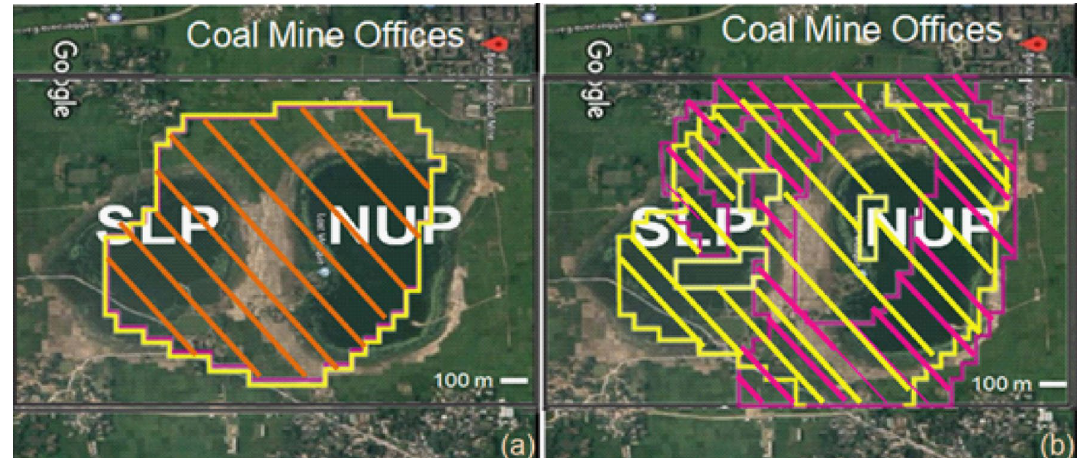
Figure 13. Future subsidence scenario of the mine area due to extraction of 30 m coal seam. ( a ) Subsided area (2 m boundary line) and ( b ) vulnerable areas considering tilt angle (.3%, yellow color) and extensile strain (.2%, magenta color). (Google 22 image, Abobe Illustrator 10, https:// www. adobe. com/ produ cts/ illus trator.